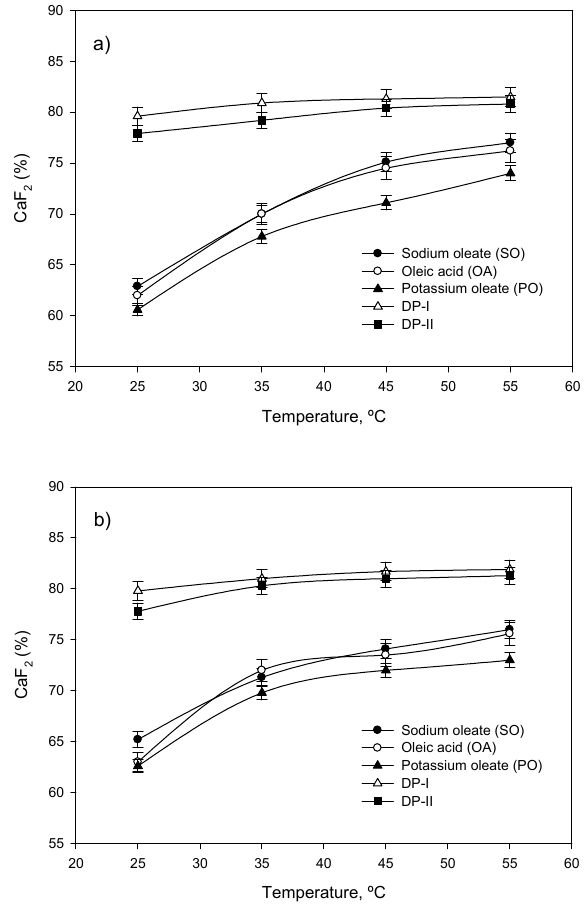
Figure 9. Effect of temperature on the CaF 2 grade in the mechanical cell ( a ) and pneumatic cell ( b ) froth flotation. froth